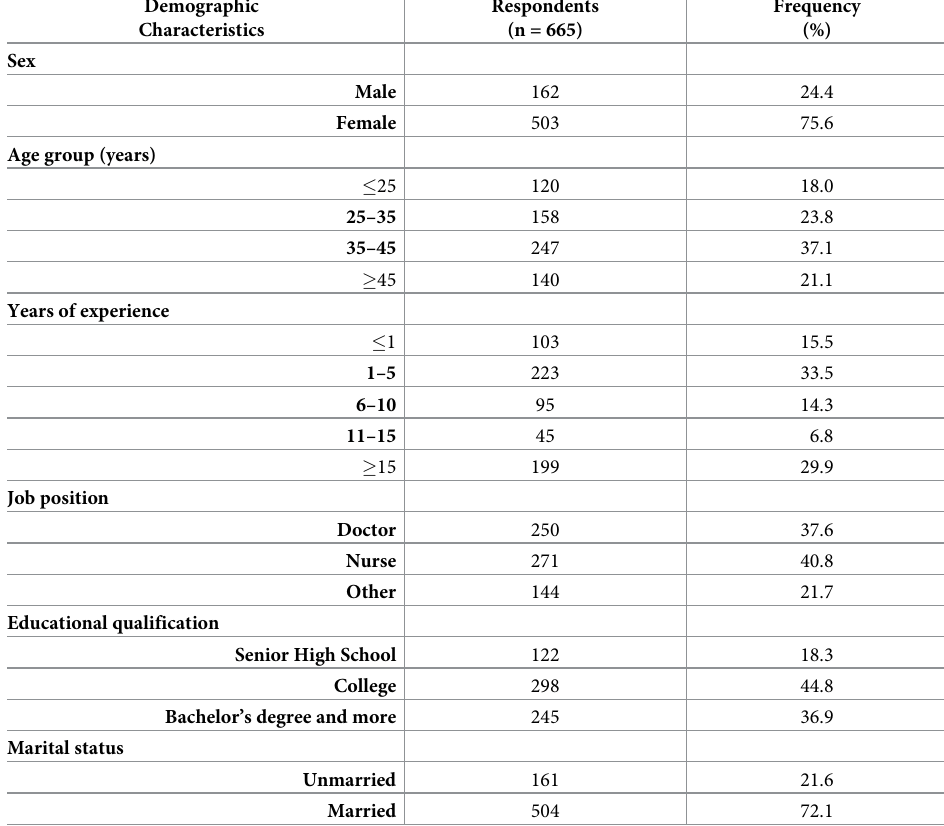
Table 1. Demographic characteristics of